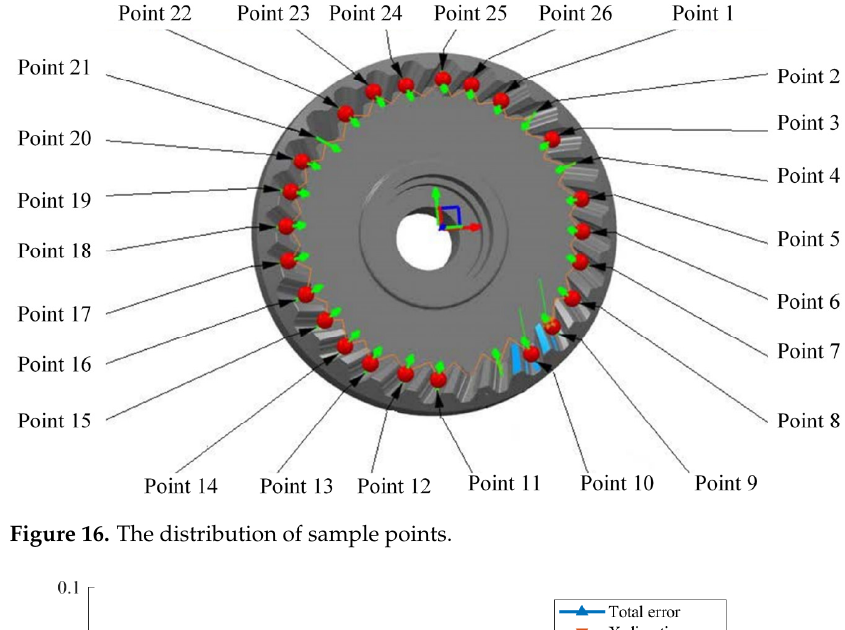
Figure 16. The distribution of sample points.